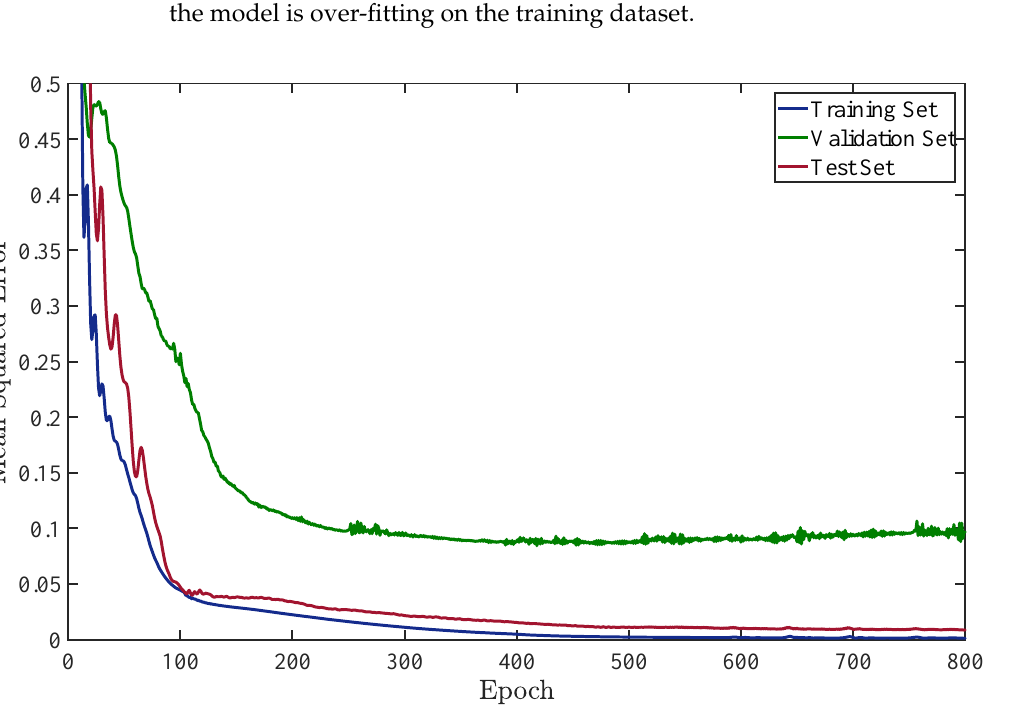
Figure 11. Learning curve showing the effect of the number of training epochs on the loss functions of training, validation, and test sets for the heterogeneous regime ANN